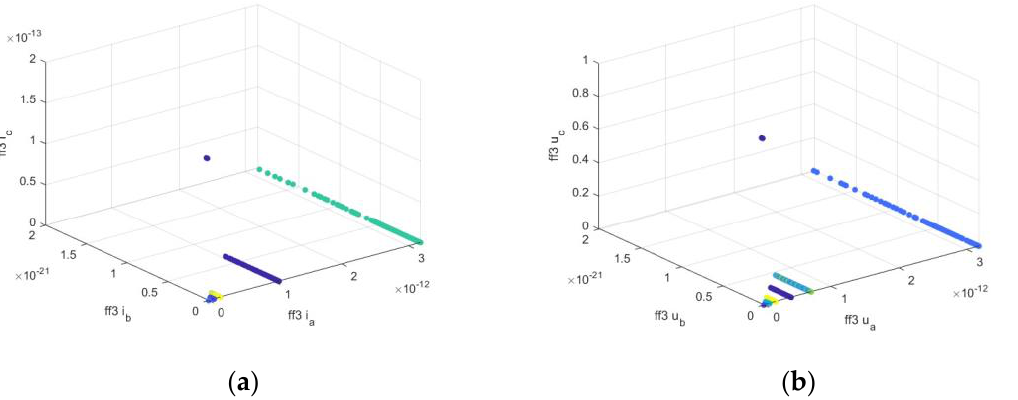
Figure 16. Dependence of the third-order harmonic amplitude of the fast Fourier transform of the ( a ) currents 𝑖 𝑎 , 𝑖 𝑏 , 𝑖 𝑐 and ( b ) voltages 𝑢 𝑎 , 𝑢 𝑏 , 𝑢 𝑐 .